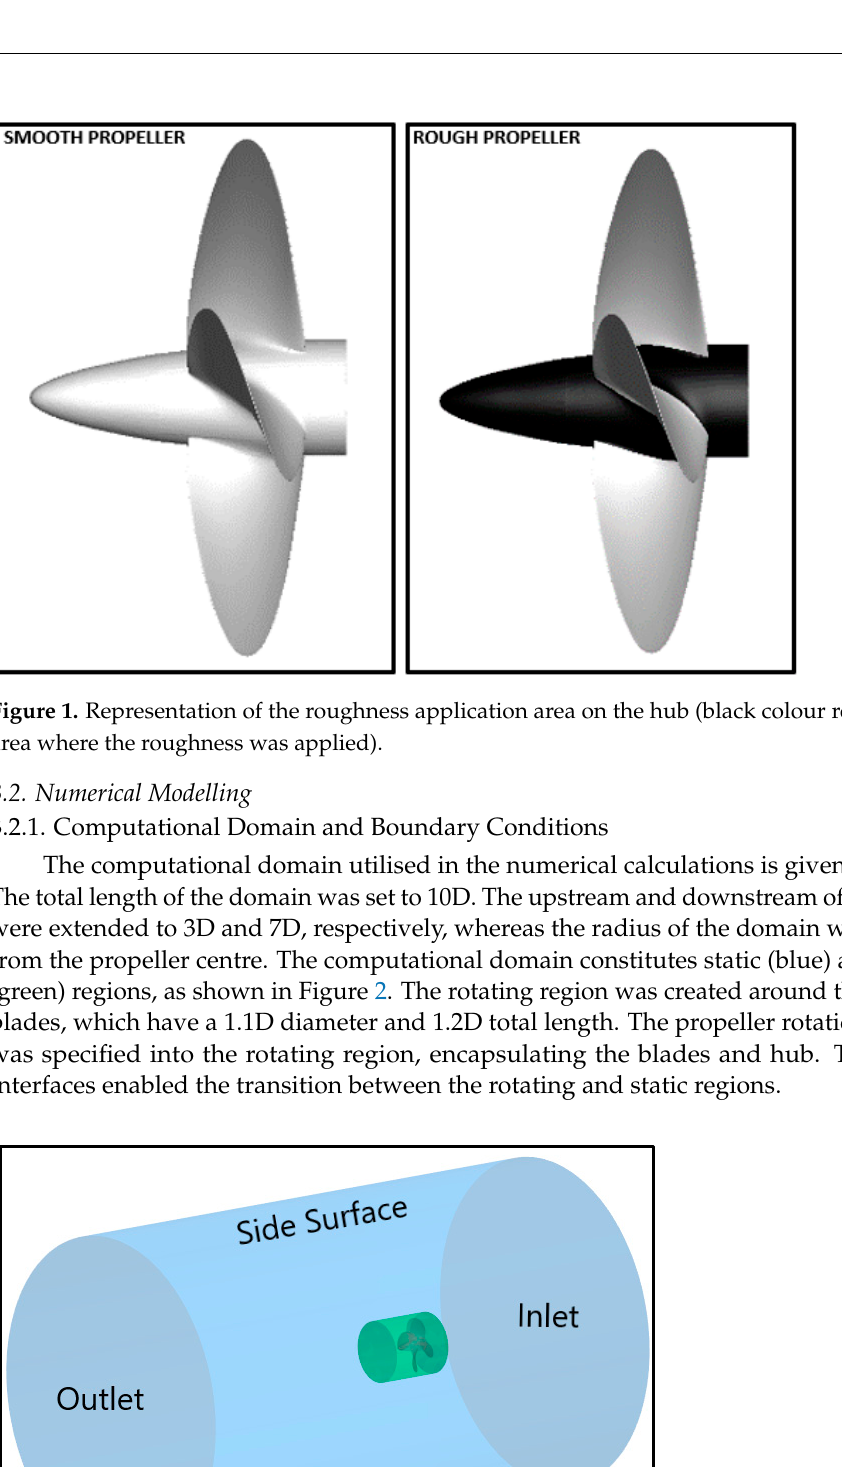
Figure 2. The computational domain used in the numerical calculations.